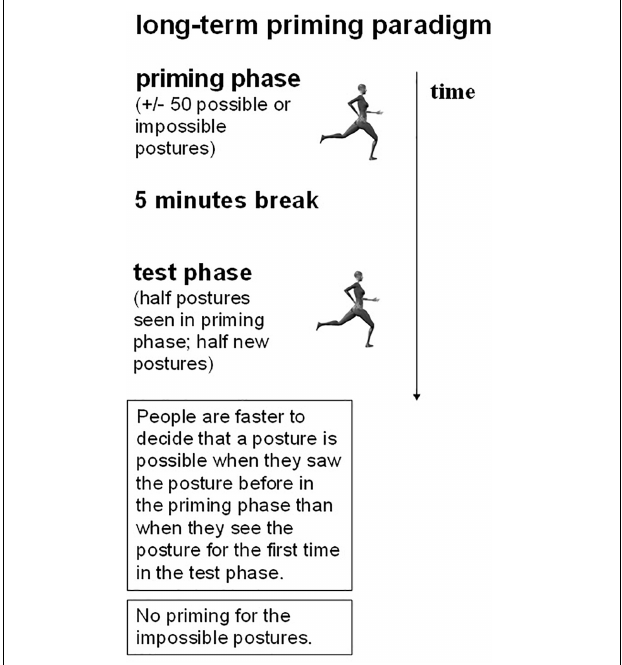
FIGURE 3 | Illustration of the basics of the long-term priming paradigm.